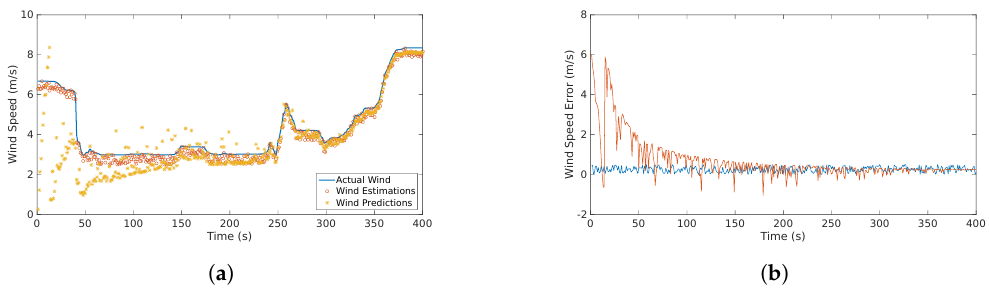
Figure 11. Actual, estimated an predicted wind speed ( a ) and wind speed error ( b ) in the considered scenario. The predicted wind starts with high dispersion, however, it converges to the actual value within 100